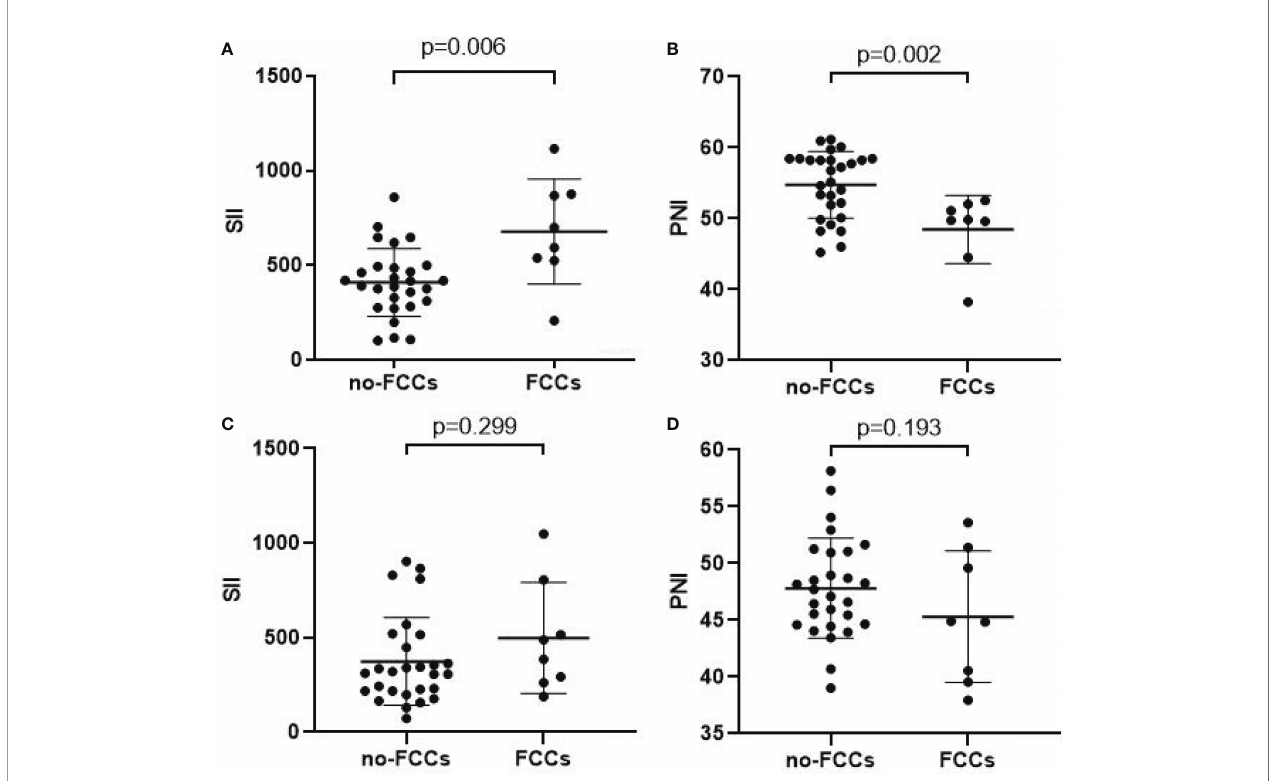
FIGURE 3 | Relationship between tumor response and the SII(A/C)/PNI(B/D). (A, B) Before conversion therapy; (C, D) After 3 cycles of conversion